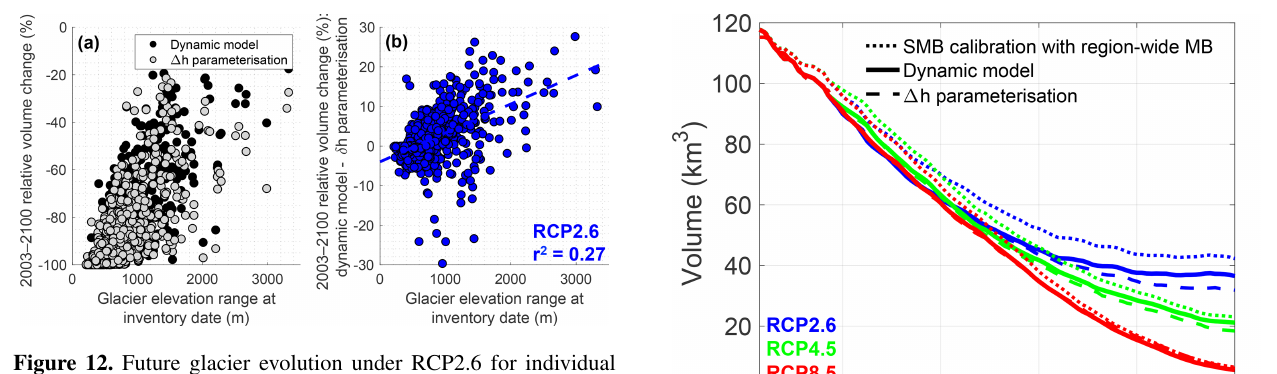
Figure 12. Future glacier evolution under RCP2.6 for individual glaciers with the dynamic model and corresponding glacier simula- tion with the (cid:49)h parameterisation. All values correspond to RCP2.6 multi-model mean values.